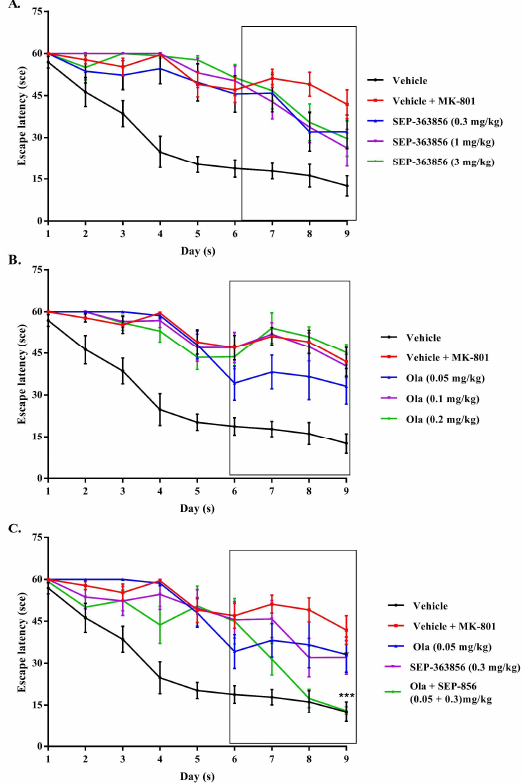
Figure 3. The effects of SEP-363856 and olanzapine on MK-801-induced memory impairment in Morris water maze behavior in mice. Date expressed as mean ± S.E.M. ( n = 8). ( A ) Effect of SEP- 363856 (0.3, 1, 3 mg/kg, p.o.). ( B ) Ola (0.05, 0.1, 0.2 mg/kg, i.p.), and ( C ) co-administration of Ola (0.05 mg/kg) and SEP-363856 (0.3 mg/kg) on MK-801-induced memory impairment in Morris water maze behavior in mice. The black box represents the period of treatment with olanzapine, SEP-363856, or their combination. (In the co-administration group, the ninth day, *** p < 0.001, model group vs. Ola + SEP-363856).